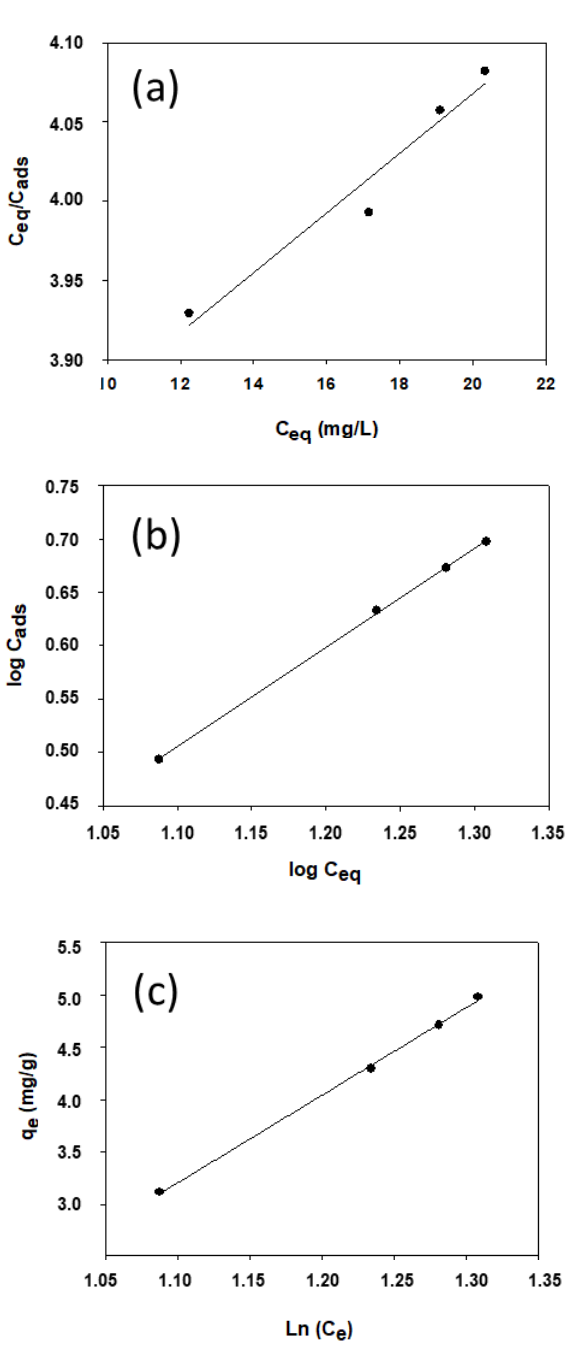
Figure 5. Langmuir ( a ), Freundlich ( b ), and Temkin ( c ) plots for 4-NPhOH adsorption on the HT-